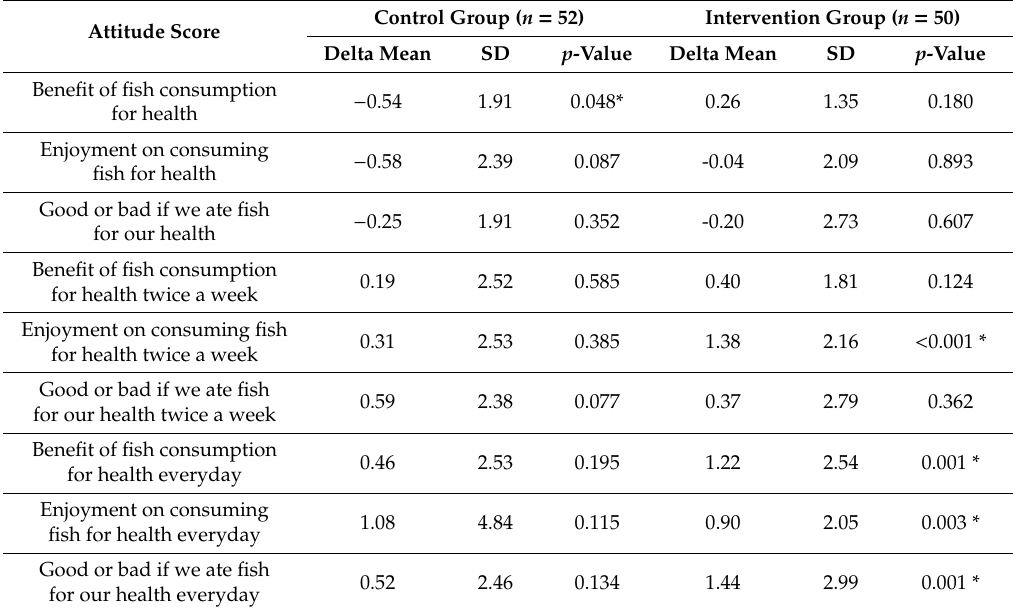
Table 3. Change in children’s attitude towards fish consumption after 3 months of intervention. Control Group ( n = 52) Intervention Group ( n = 50) Attitude Score Delta Mean SD p -Value Delta Mean SD